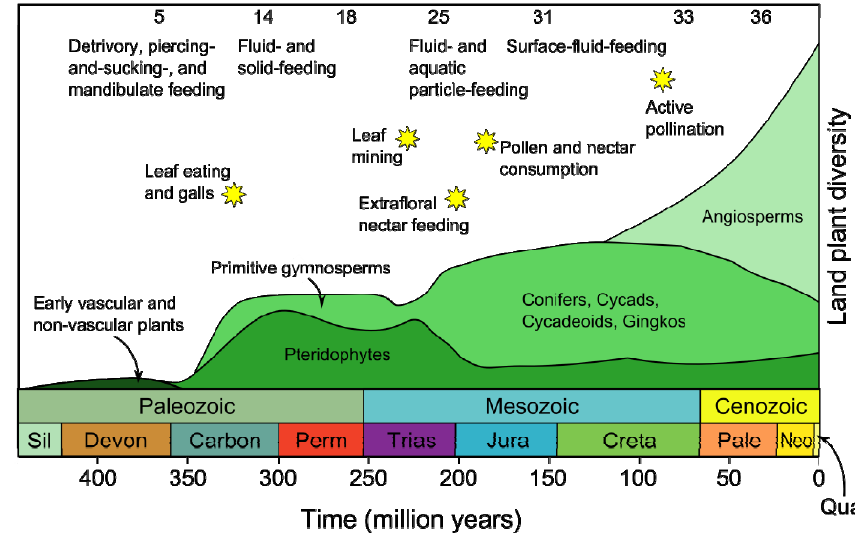
Figure 1. Evolutionary development of plant classes and insect feeding